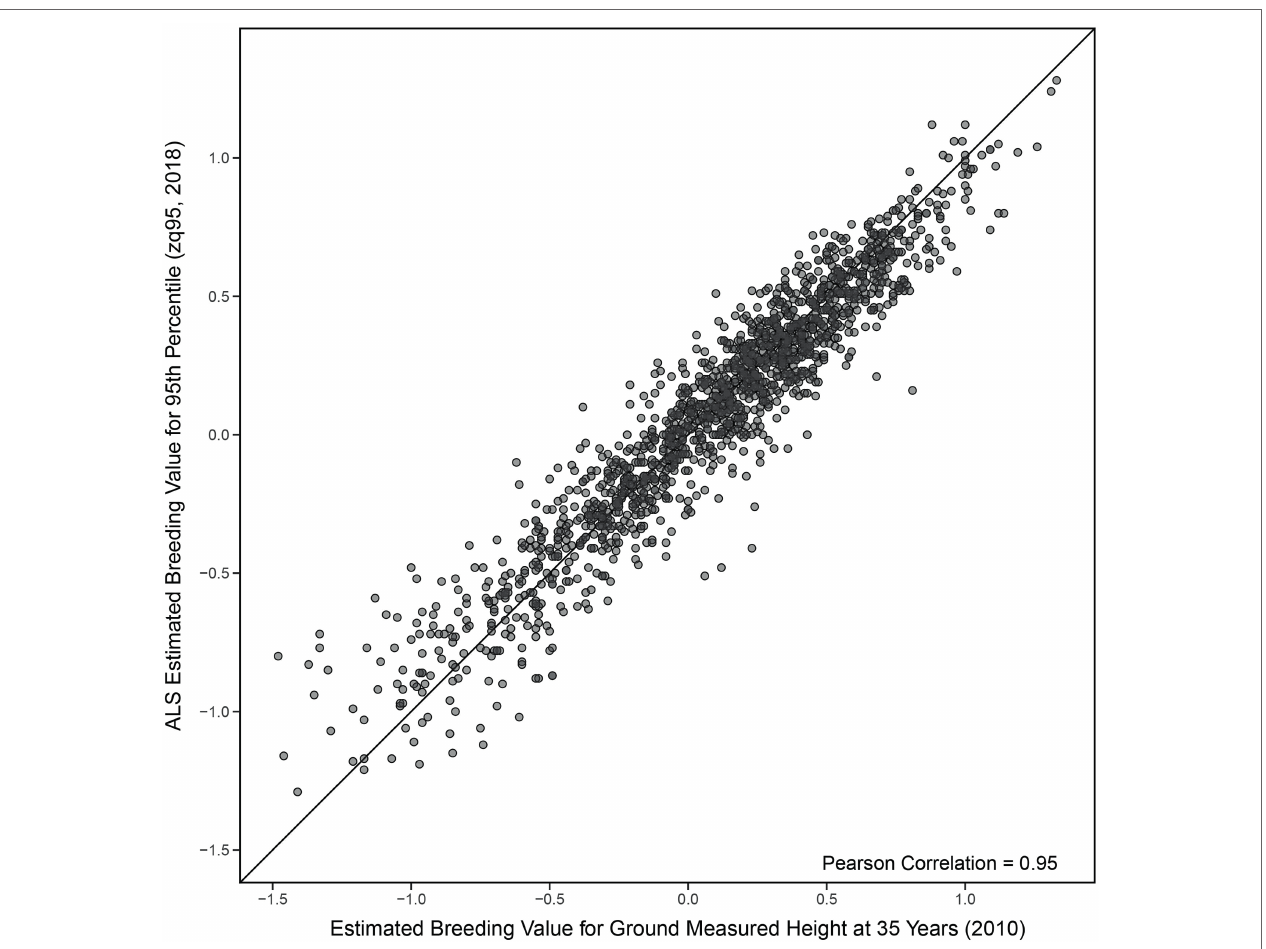
FIGURE 3 | Comparison of univariate estimated breeding values (Equation 1) for the 95th percentile of height-derived from ALS taken in 2018 and field-measured height at 35 years in 2010. The black line represents a 1:1